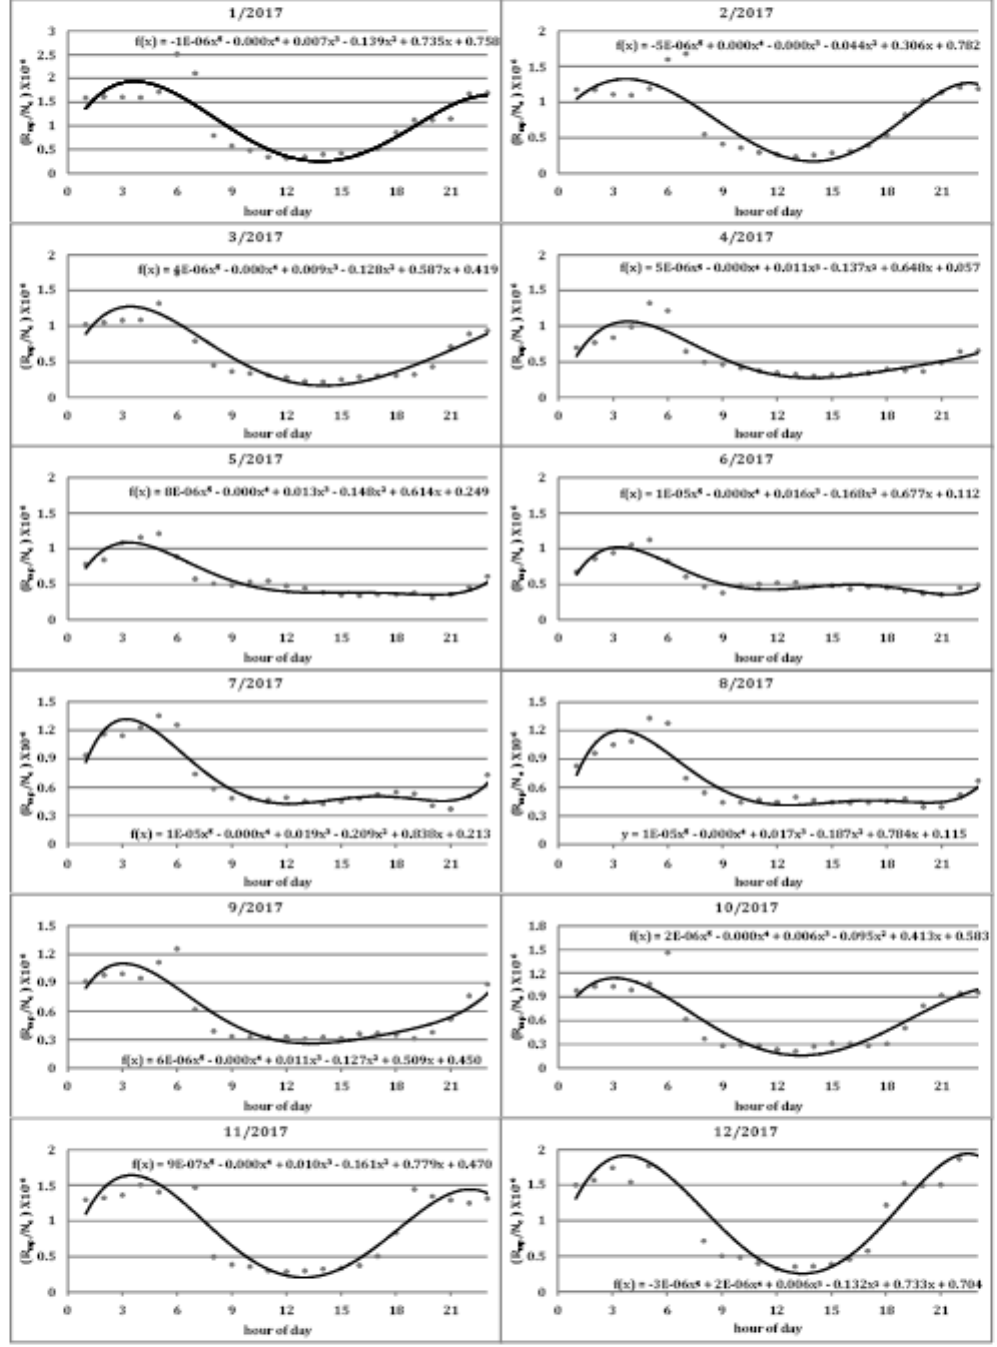
Fig. 10: Monthly median of (Rmp /Ne) for year